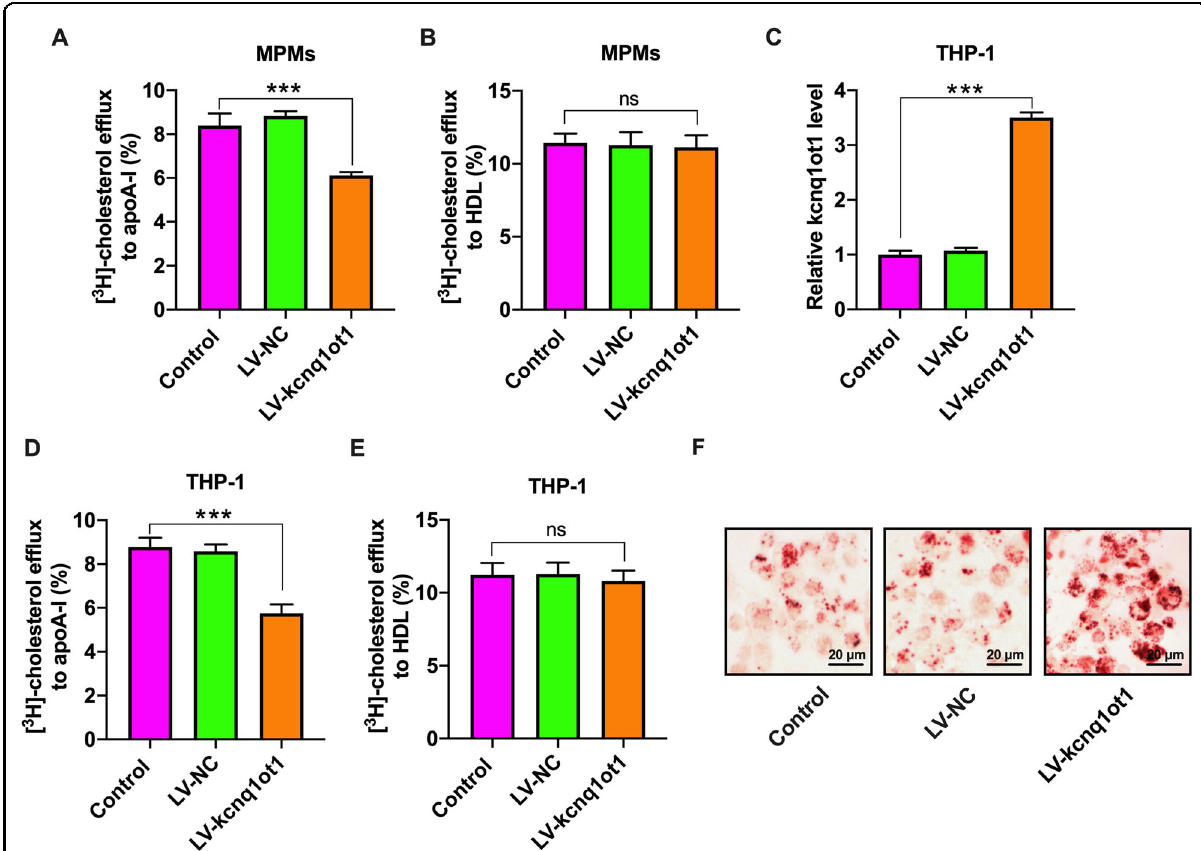
Fig. 3 Effects of kcnq1ot1 on cholesterol ef fl ux and lipid accumulation in MPMs and THP-1 macrophages. A , B After 48h of incubation with [ 3 H]-cholesterol, liquid scintillation counter was used to measure cholesterol ef fl ux from MPMs to apoA-I or HDL ( n = 5). C – F THP-1 macrophages were pretreated with or without 50µg/mL ox-LDL for 48h, and then transduced with PBS, LV-NC, or LV-kcnq1ot1 for 72h ( n = 3). C kcnq1ot1 expression was detected by qRT-PCR. D , E The ef fl ux of cholesterol to apoA-I or HDL. F Representative images of Oil red O staining (400×). Scale bar = 20 μ m. Data are represented as mean ± SD. *** P < 0.001; ns not signi fi